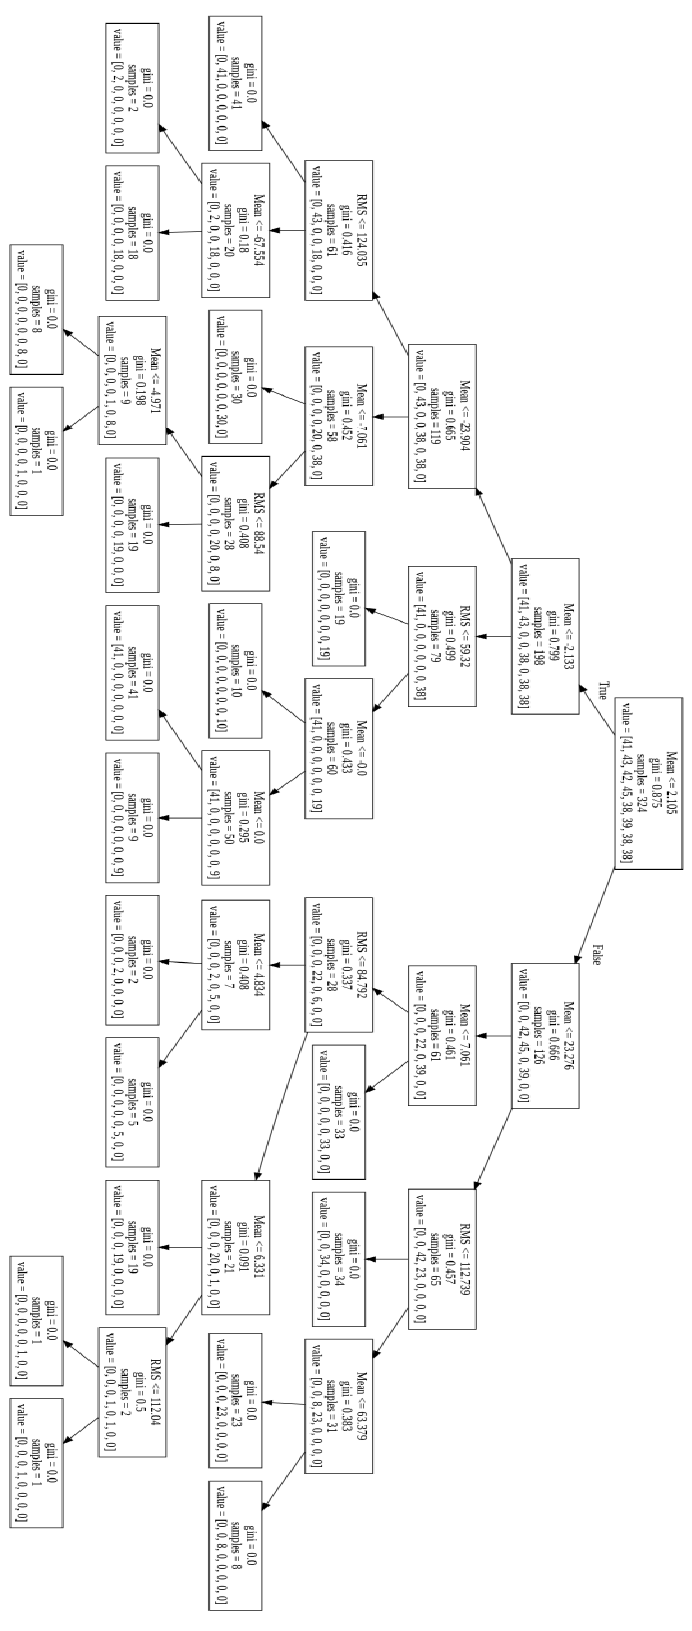
Figure 12. Obtained decision tree.